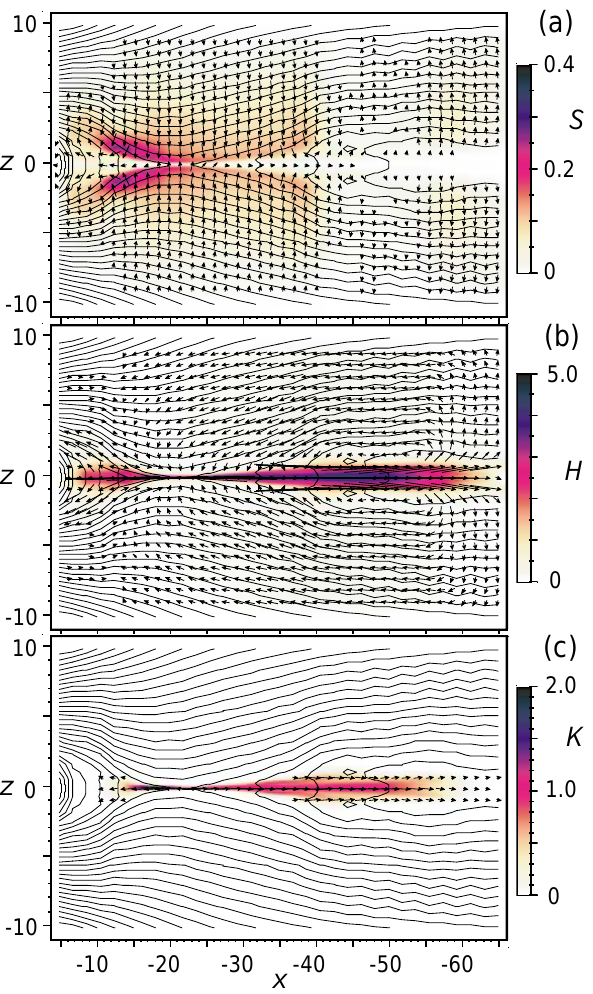
Fig. 2. Energy fluxes at t = 80, integrated over y from y = 0 to y = 10: (a) Poynting flux, S = E × B , (b) enthalpy flux, H = (p + u) v , and (c) kinetic energy flux, K = (ρv 2 / 2 ) v . Color indicates the magnitude of the fluxes, while the arrows show the flux vectors. Only flux vectors with fluxes exceeding 0.005 in magnitude are shown.